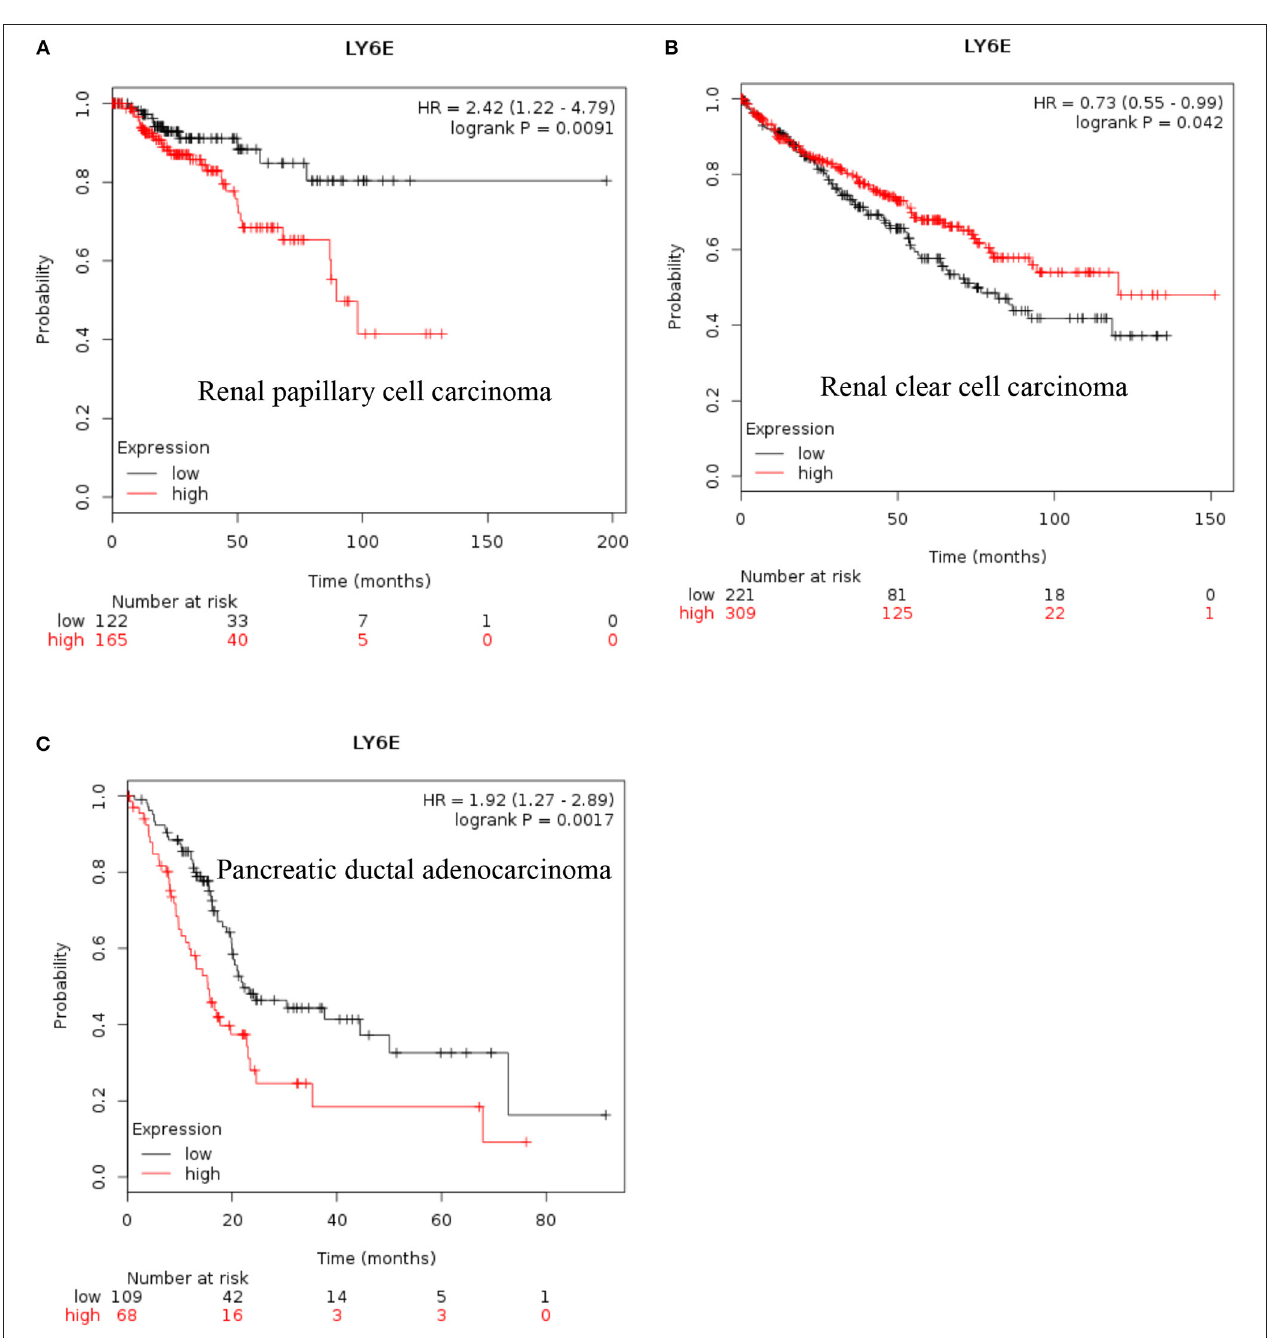
FIGURE 2 | Increased LY6E mRNA expression in cancer and patient survival. High LY6E RNA expression leads to (A) poor survival in renal papillary cell carcinoma, (B) good prognosis for renal clear cell carcinoma, (C) poor survival in pancreatic ductal adenocarcinoma. These data were recently added in Km plotter webtool from RNA seq pan cancer analysis